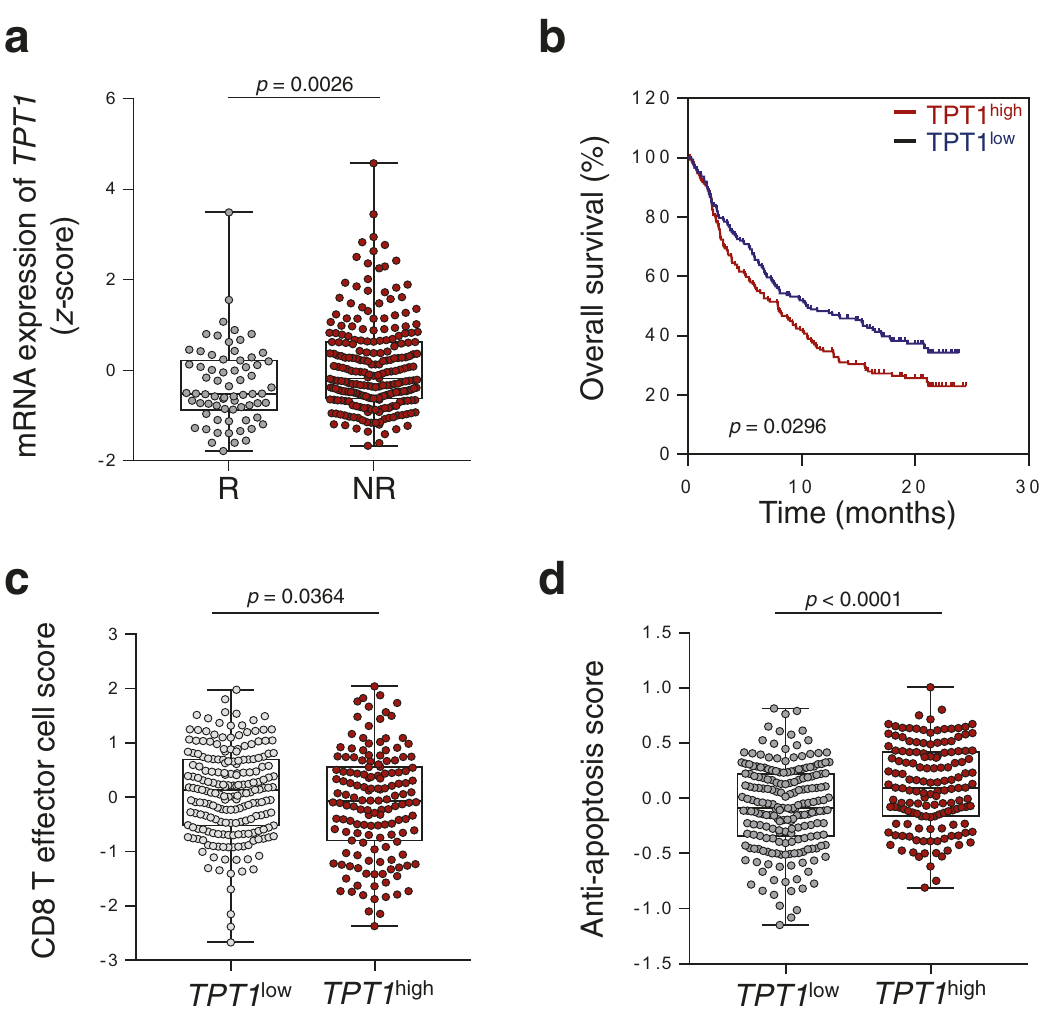
Fig. 1 Increased expression of TPT1 is associated with immune-refractory non-responder phenotype to anti-PD-L1 therapy. a Comparison of TPT1 expression in responders (R, n = 68) and non-responders (NR, n = 230). b Kaplan – Meier analysis of overall survival (calculated as months to death or months to last follow-up) and median expression cutoff values for the expression level of TPT1 ( TPT1 high > average; TPT1 low < average). The p value